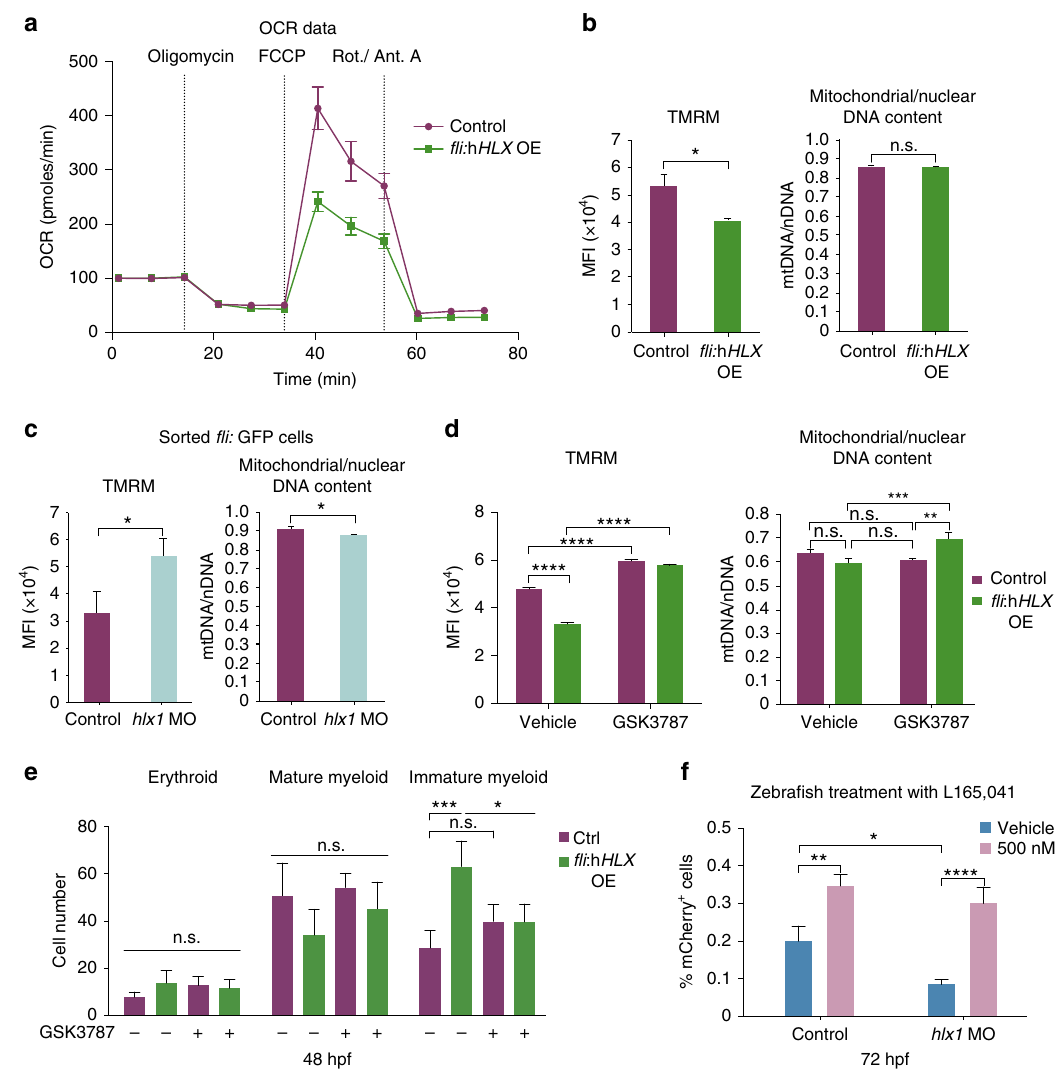
Fig. 3 PPAR δ modulation can rescue HSPC formation and myeloid differentiation in zebra fi sh. a Oxygen consumption rate (OCR) in control or fl i :h HLX OE zebra fi sh. Representative plot from three independent experiments (mean ± s.d.). b – c Mitochondrial membrane potential measured by TMRM stain (left panel) and mitochondrial/nuclear DNA content analysis (right panel) in ( b ) control and fl i :h HLX OE embryos or in ( c ) endothelial/hematopoietic cells ( fl i: GFP positive) of control and hlx1MO embryos at 48 hpf ( n = 3, mean + s.d., Student ’ s t -test, * P < 0.05). Graphs for TMRM depict median fl uorescence intensity (MFI). The ratio of mitochondrial DNA (mtDNA) vs. nuclear DNA (nDNA) was measured at the same time ( n = 3, mean + s.d., Student ’ s t -test, * P < 0.05, n.s. non-signi fi cant). d Mitochondrial membrane potential at 48 hpf (left panel) in control or fl i :h HLX OE embryos after GSK3787 treatment and corresponding ratio of mtDNA/nDNA (right panel) ( n = 3, mean + s.d., ANOVA test, ** P < 0.01, *** P < 0.001, **** P < 0.0001). e Cell count of zebra fi sh CHT smears from control or fl i :h HLX OE embryos at 48 hpf after treatment with GSK3787 ( n = 4, mean + s.d., Student ’ s t -test, * P < 0.05, *** P < 0.001). f Percentage of Runx : mCherry HSPCs in Tg(Runx:mCherry) control or hlx1MO embryos at 72 hpf after L165,041 (PPAR δ agonist) treatment ( n = 3, mean + s.d., ANOVA test, * P < 0.05, ** P < 0.01, **** P <